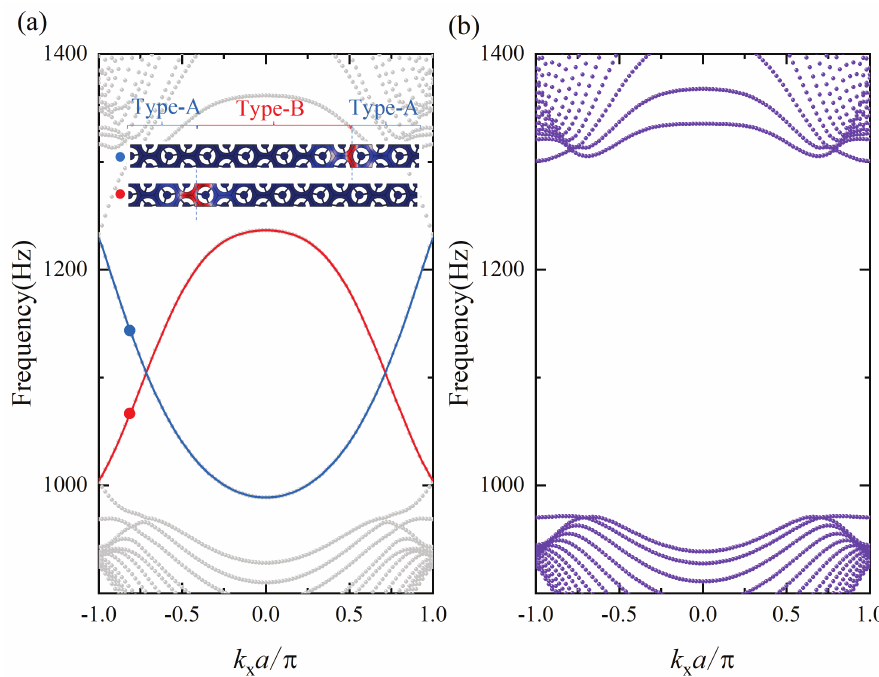
Figure 4. Projection band structure diagram of the supercell and its displacement field distribution: ( a ) the band structure of the ABA thin plate and the displacement field of the red and blue two points; ( b ) the band structure of all A-type thin